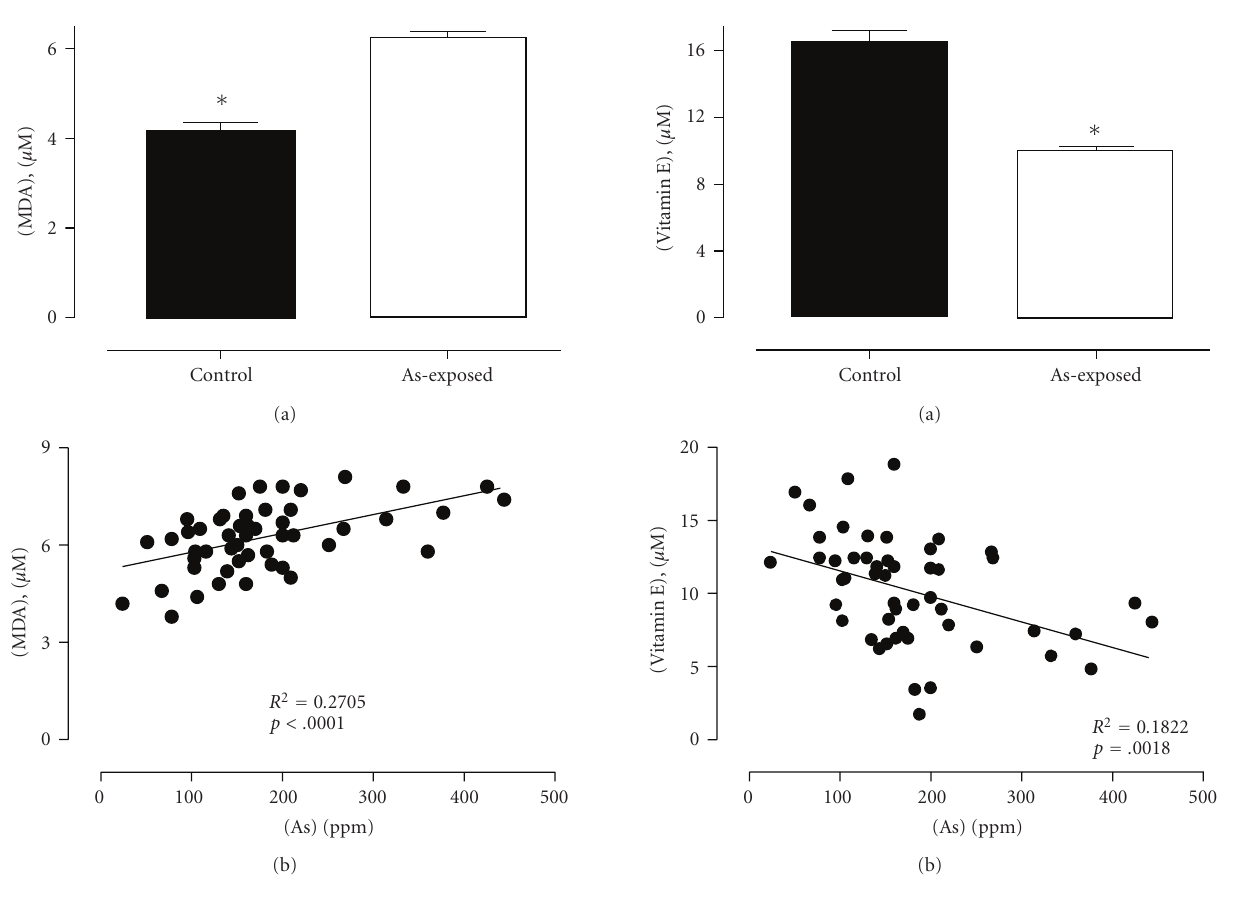
Figure 2: Comparative e ff ect of arsenic exposure on lipid per- oxidation in blood samples from low- and high-exposure human populations. (a) Comparison of MDA distribution profile in blood samples isolated from low-As-exposure (control, n = 31) and high-As-exposure ( n = 50) human populations. Lipid peroxidation was assessed by plasma MDA concentration. The statistical analysis indicates significant di ff erences between the two groups (test U-Mann-Whitney P < . 0001). (b) Correlation between MDA concentration and urinary excretion of As in the high As-exposure population ( n = 50). The associations between the two variables were determined by R -Pearson ( P < . 0001).